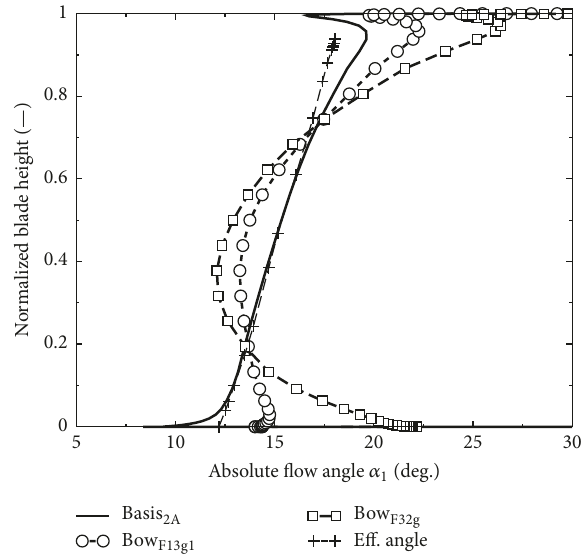
Figure 11: Circumference averaged exit flow angle of the stators over the